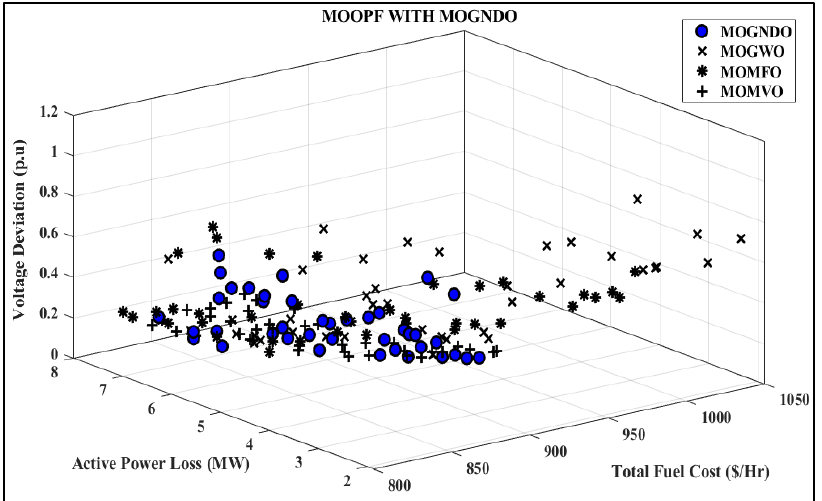
Figure 24. PF of TFC, APL, and voltage deviation minimization with different algorithms. Table 13. Multi-objective simulation results for case 7 and case 8.